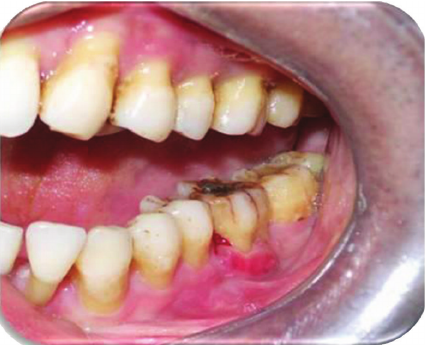
Figure 1: Preoperative view.